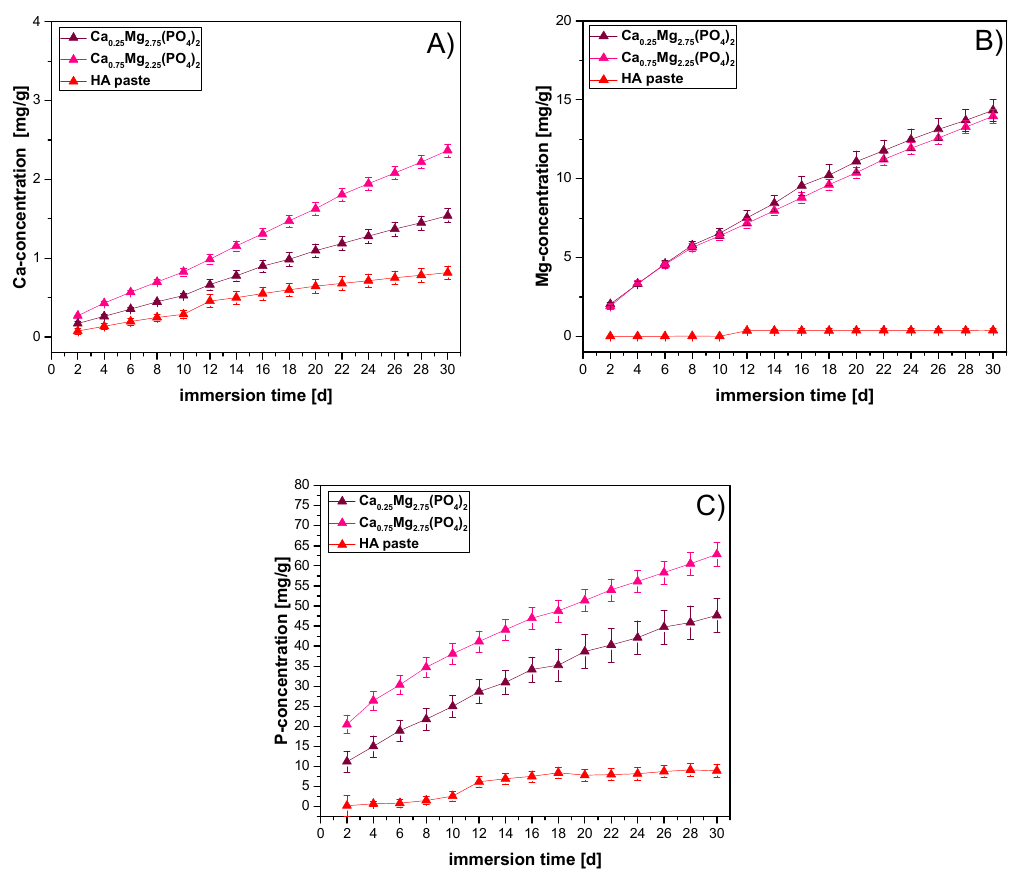
Figure 3. Cumulative calcium- ( A ), magnesium- ( B ) and phosphate release ( C ) from the premixed CaMgP and HA forming cement pastes during incubation in PBS for 30 d at 37 °C. Values are given as mass of dissolved ions related to one gram of set cement. Table 1. Cumulative release of calcium, magnesium and phosphate from samples prepared from premixed CaMgP cement pastes after 30 d immersion in PBS at 37 °C.